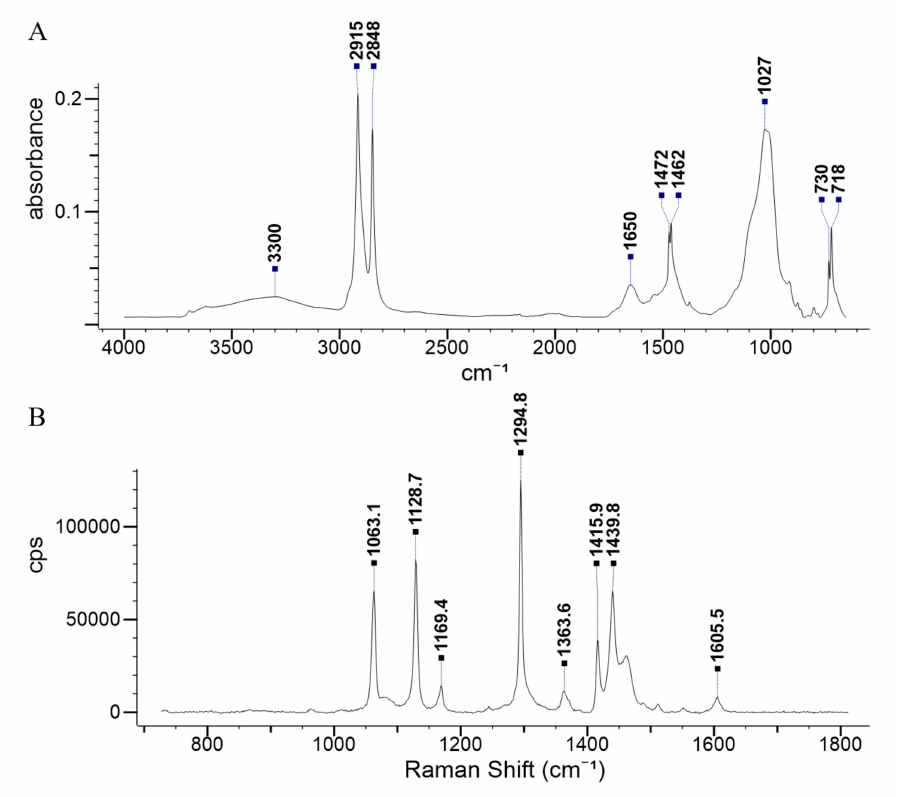
Figure A1. Confirmation of the MP type as high-density polyethylene (HDPE) with ( A ) Fourier transform infrared (FTIR) spectra and ( B ) Raman